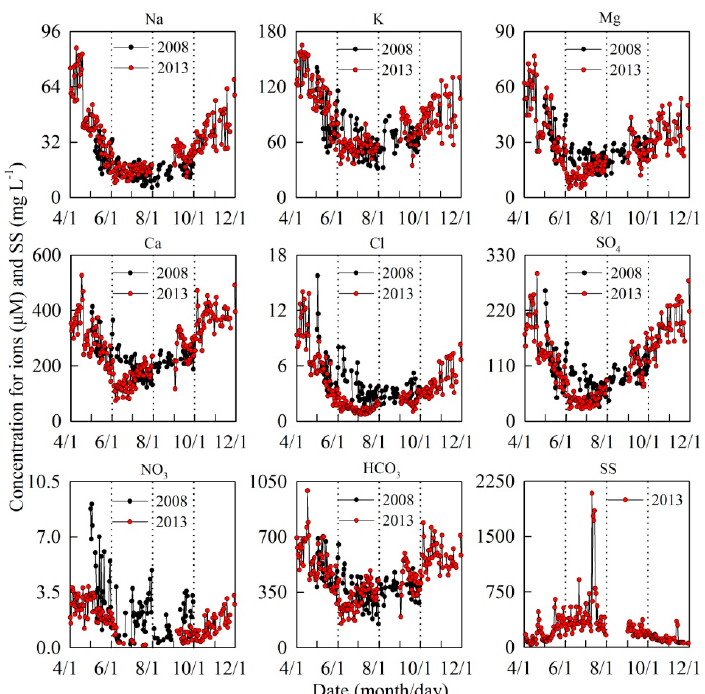
Figure 3. Seasonal variations in the concentrations of major ions and suspended sediments (SS) in river water at the Hailuogou basin over two melt seasons in 2008 and 2013.